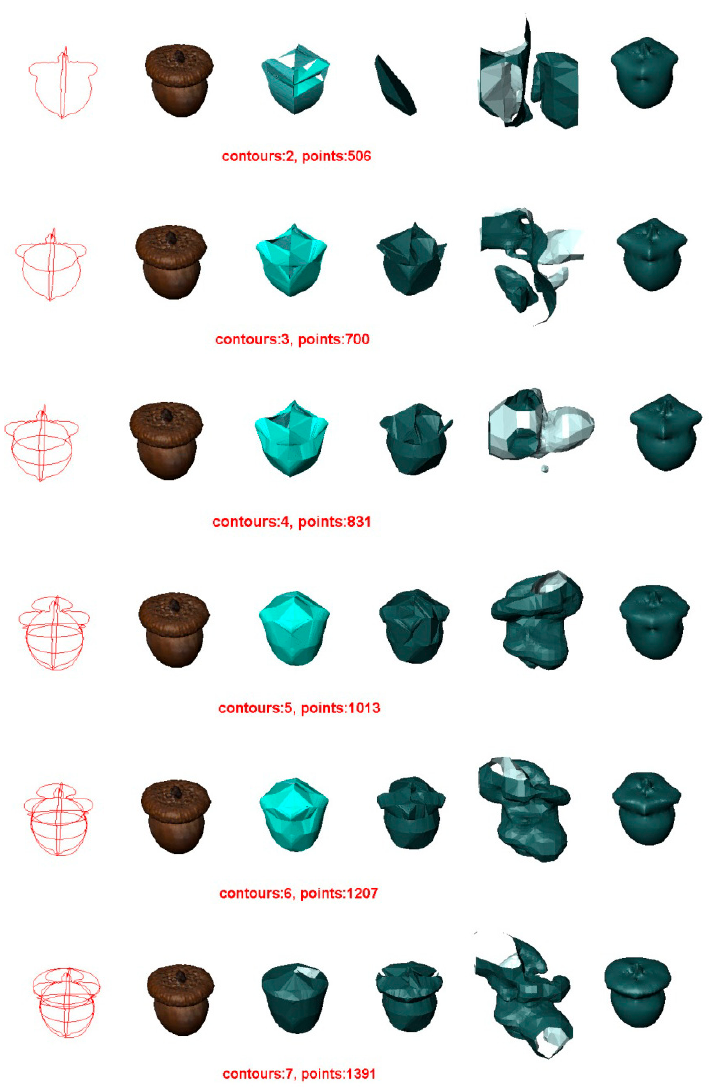
Figure 4. Surface reconstruction of an acorn by four methods. For each row, from left to right: the contours used, the original surface, the surface reconstructed by BPA, the surface reconstructed by Power Crust, the surface reconstructed by Poisson, and the surface reconstructed by